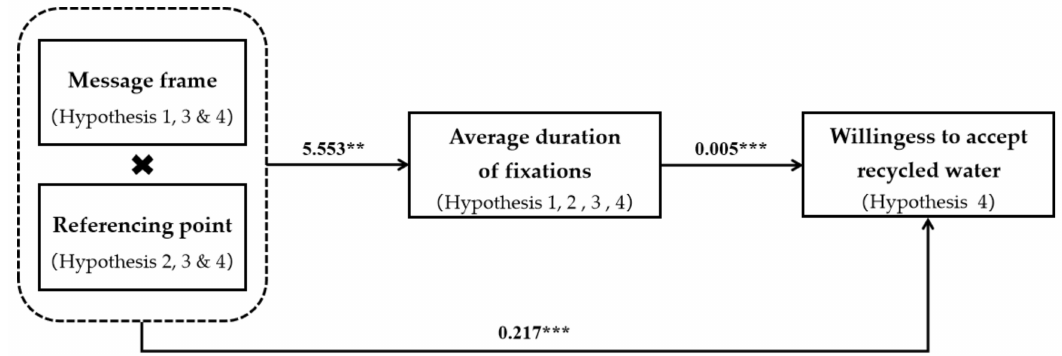
Figure 7. Mediating effect of Average duration of fixations. (Note: The values in the Figure 7 are standardized regression coefficients; ** p < 0.01, *** p <